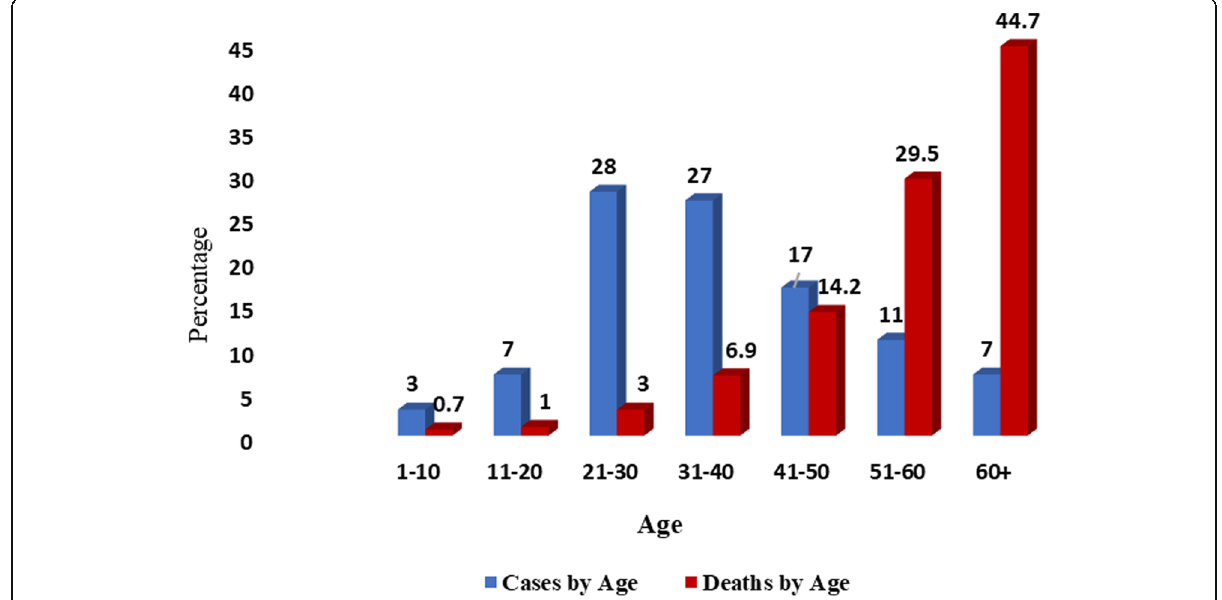
Fig. 3 Case and death percentage by ages in